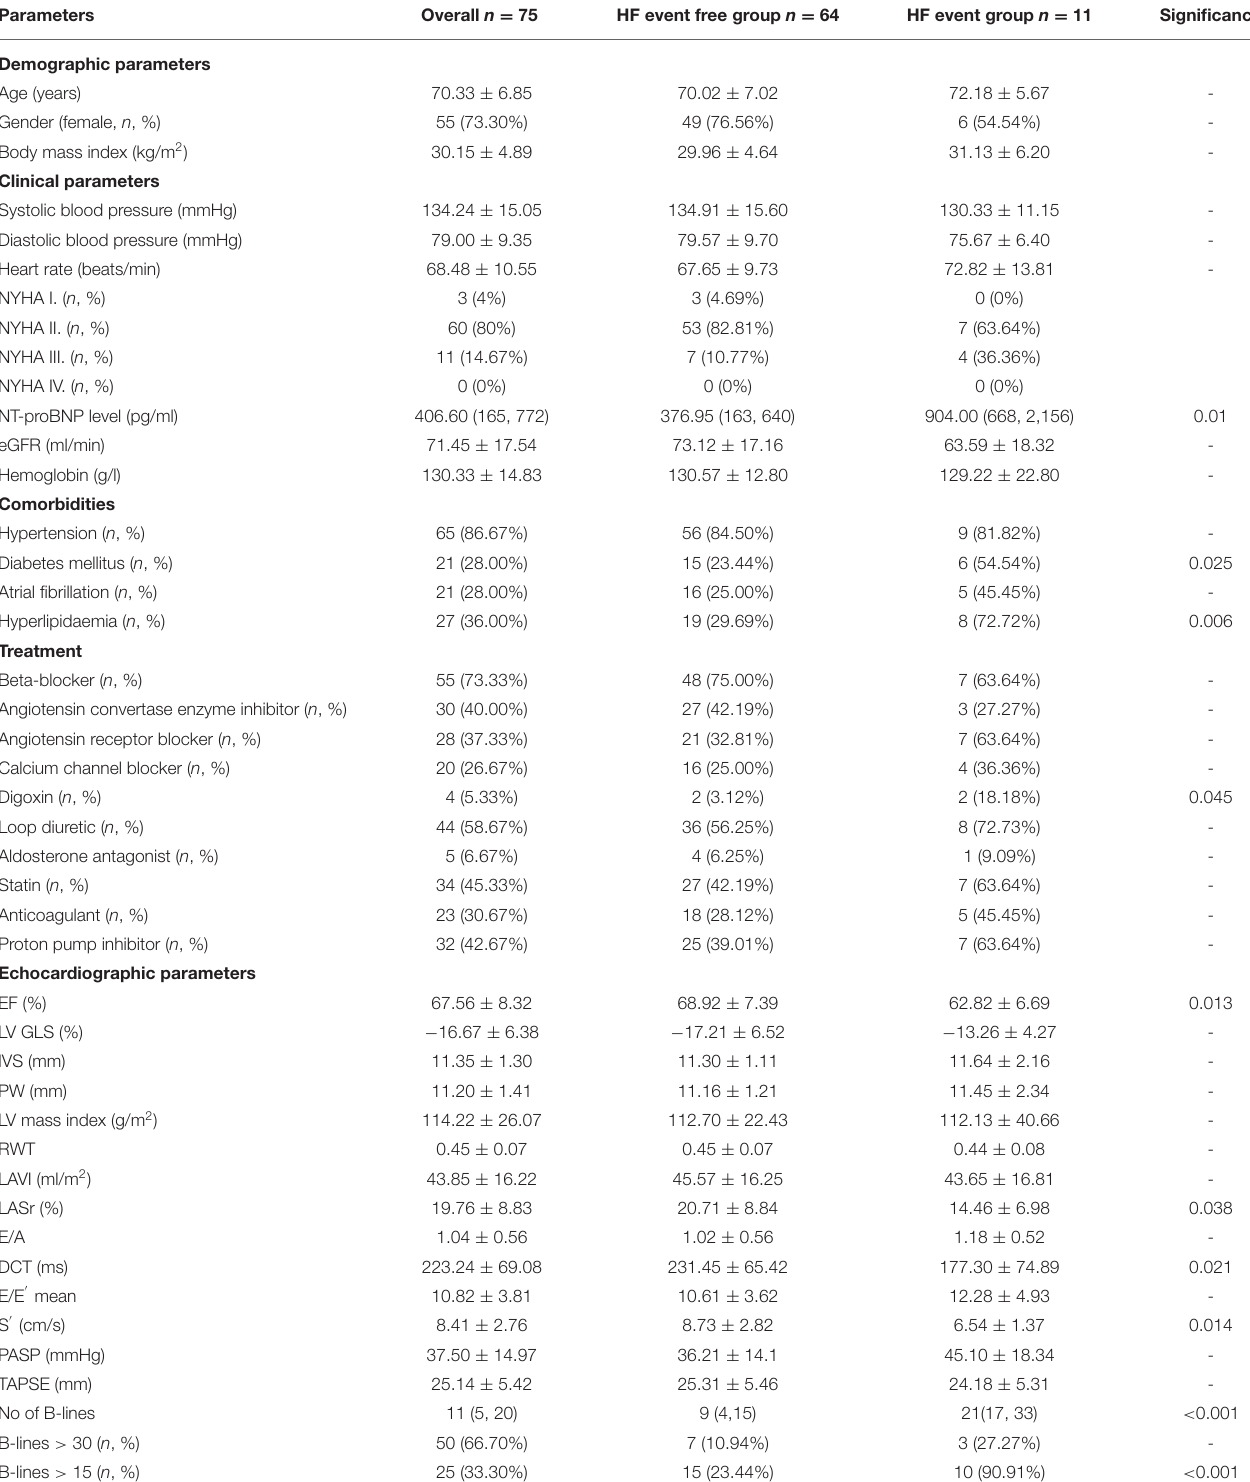
TABLE 1 | Baseline demographic and echocardiographic